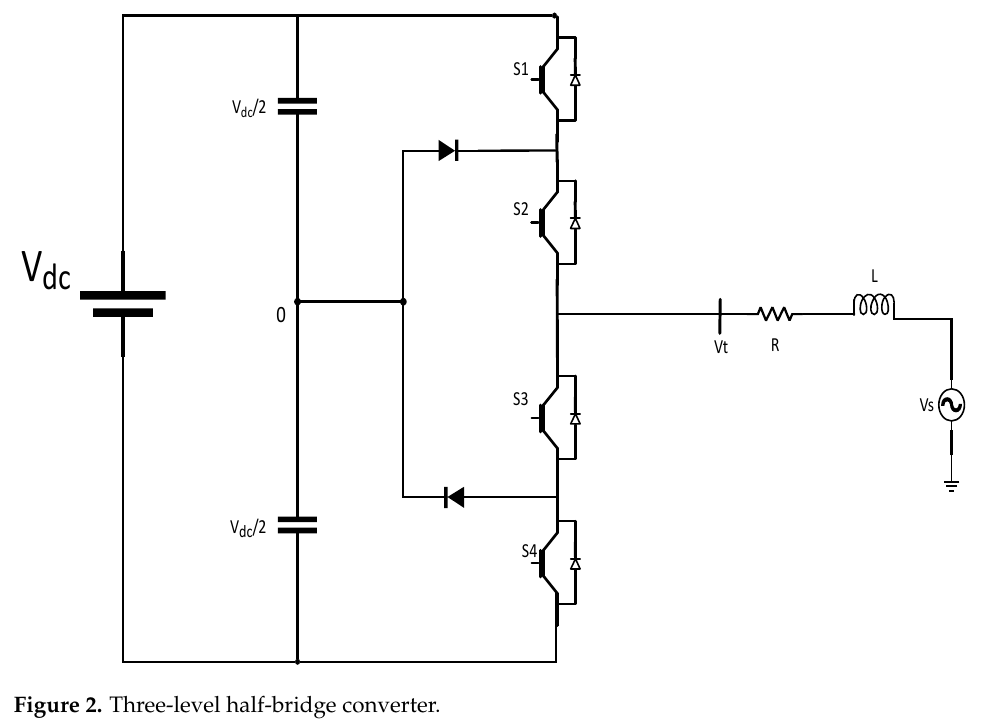
Figure 2. Three-level half-bridge converter.